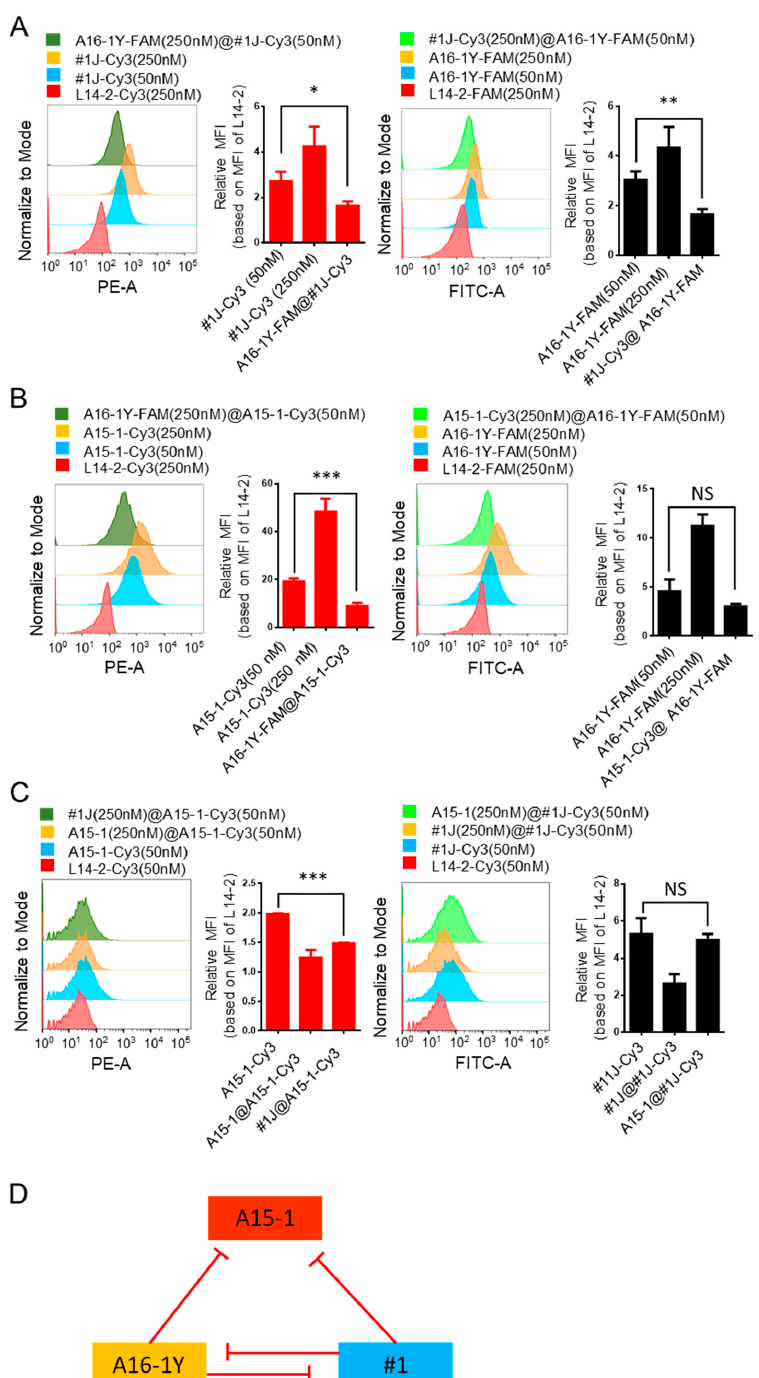
Figure 7. Competitive binding of A15-1, A16-1Y, and #1J aptamers to mycoplasma-infected cells. Mixed mycoplasma-infected Jeko-1 cells were pre-incubated with [250 nM] blocking aptamer for 10 min, then incubated with 50 nM testing aptamer for 15 min. Then, MFI of the test aptamer-bound cells were calculated and compared. Histogram plots of flow cytometry results are presented on the left and the corresponding quantifications are presented on the right. ( A ) Competitive binding test between A16-1Y and #1J aptamers; ( B ) competitive binding test between A16-1Y and A15-1 aptamers; ( C ) competitive binding test between A15-1 and #1J aptamers. ( D ) Diagram of the competitive binding between A15-1, A16-1Y, and #1J aptamers. Red lines indicate inhibition. “@” in the figure legends indicates the separator between blocking and testing aptamer; the aptamers before “@” are blocking aptamers and those after “@” are testing aptamers. Data show the mean ± SD of three independent experiments. * p < 0.05, ** p < 0.01, *** p < 0.001, “NS” means not